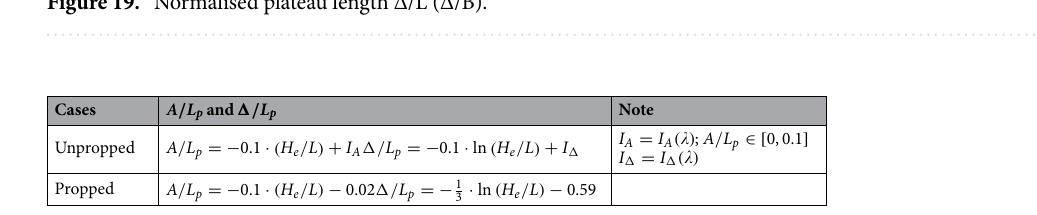
Table 6. Relationship between A, Δ and the excavation depth H e